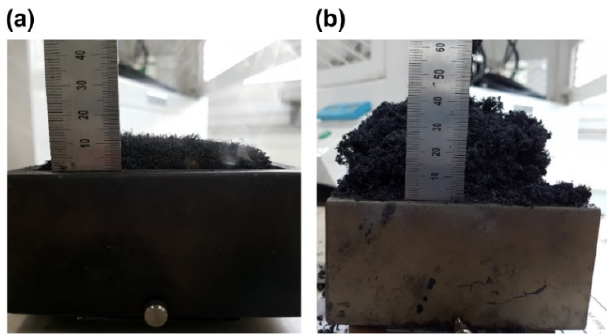
Figure 6. Images of expanded layer ( a ) EG 5 wt.% and ( b ) EG 50 wt.%.